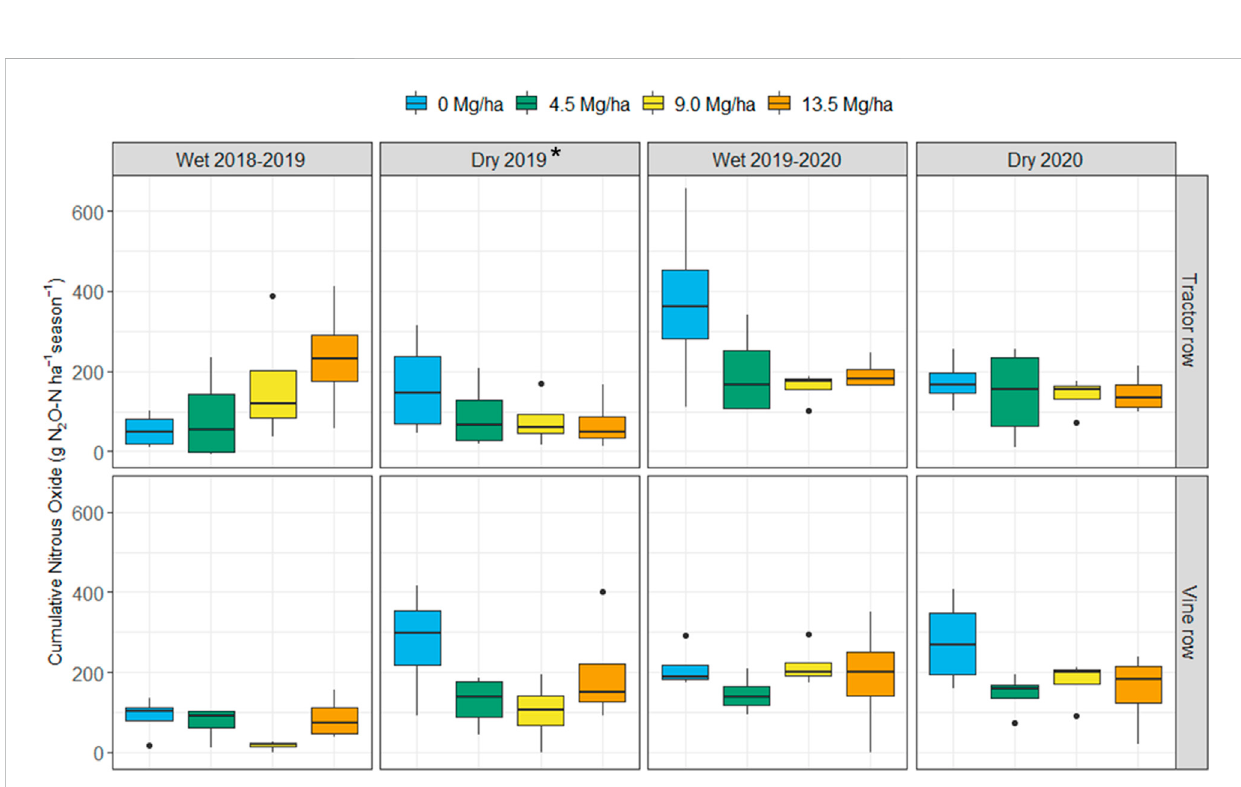
FIGURE 5 Cumulative N 2 O emissions by functional location under compost application treatments (0, 4.5, 9.0 and 13.5 Mg ha -1 ) during two wet and two dry seasons from 2018 to 2020. Error bars represent standard errors of the mean (n = 4). Asterisk (*) indicate signi fi cant differences between locations at p < 0.05 within the dry